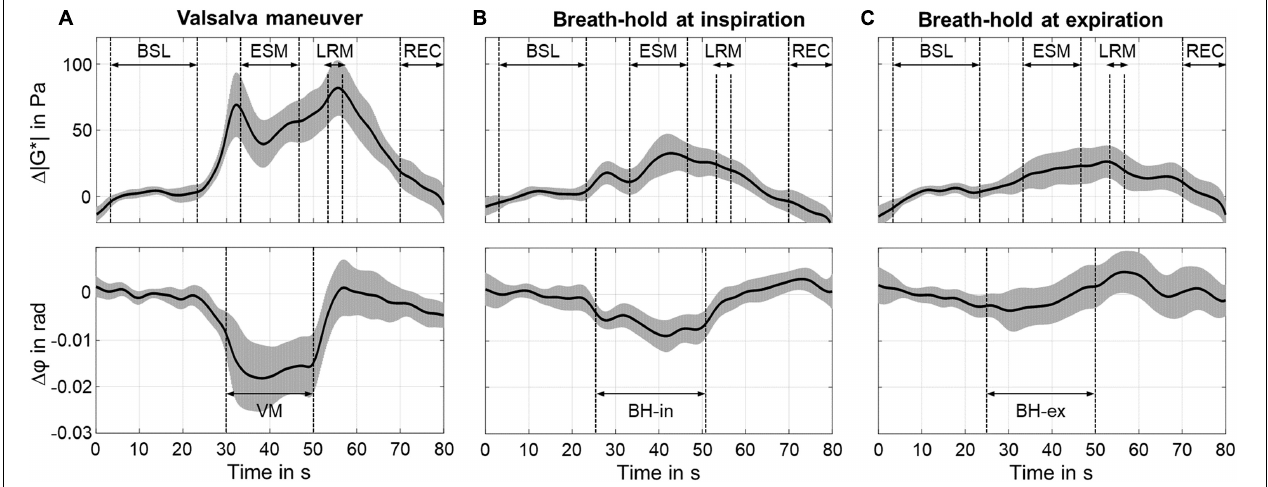
FIGURE 5 | Time courses of group mean values of (cid:49) | G*| (top of subfigures) and (cid:49) ϕ (bottom of subfigures) using the 31-Hz regimen (30.03, 30.91, 31.8 Hz). The gray areas show 95% confidence intervals. For Valsalva maneuver (VM), timing was as follows: breath-hold in inspiration (BH-in) at 25 s, start of VM at 30 s, stop of VM at 50 s. For breath-hold (BH) experiments, timing was as follows: start of BH at 25 s, stop at 50 s. (A) Valsalva maneuver (VM). (B) Breath-hold in inspiration (BH-in). (C) Breath-hold in expiration (BH-ex).